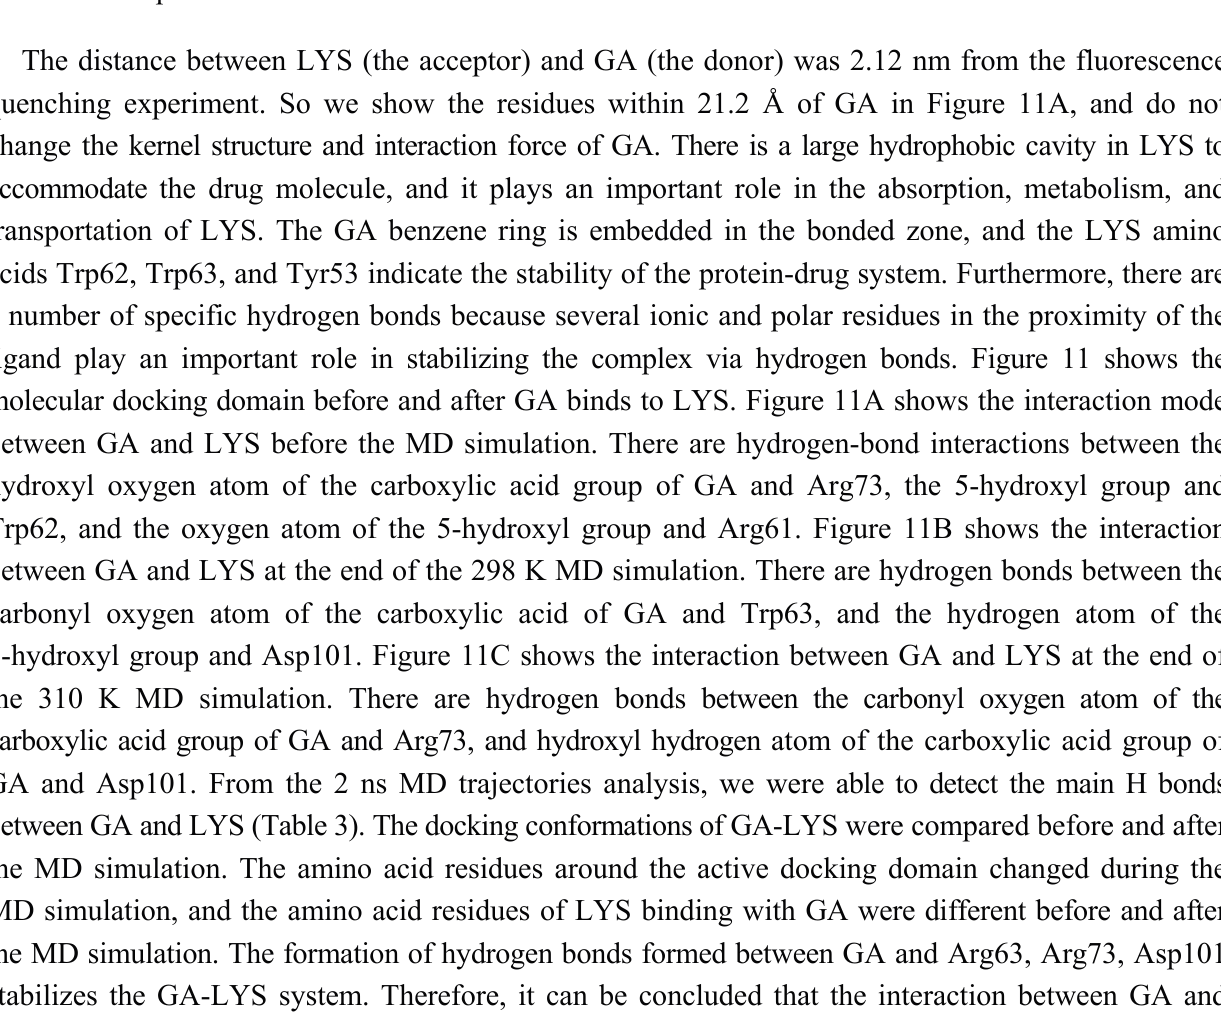
Figure 10. Interaction of GA with LYS. ( A ) Electron density and hydrophobic surface map between GA- LYS, only residues around 20.0 Å of the ligand are displayed; ( B ) Interaction mode between GA and LYS. The ligand structures are represented using a stick model, the blue sticks represented Trp residues, the red sticks represented Tyr residues, the yellow sticks represented Phe